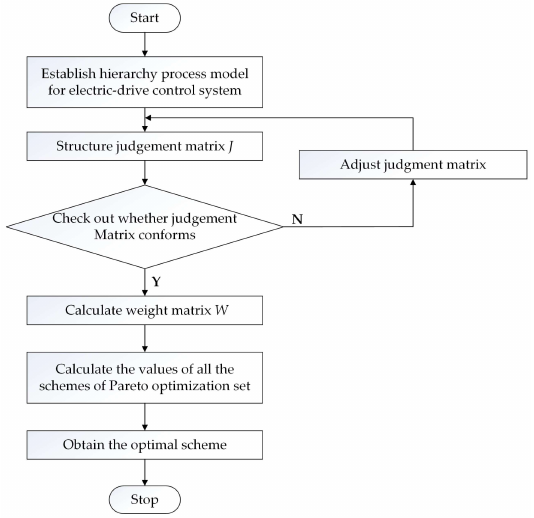
Figure 9. Flowchart of AHP.